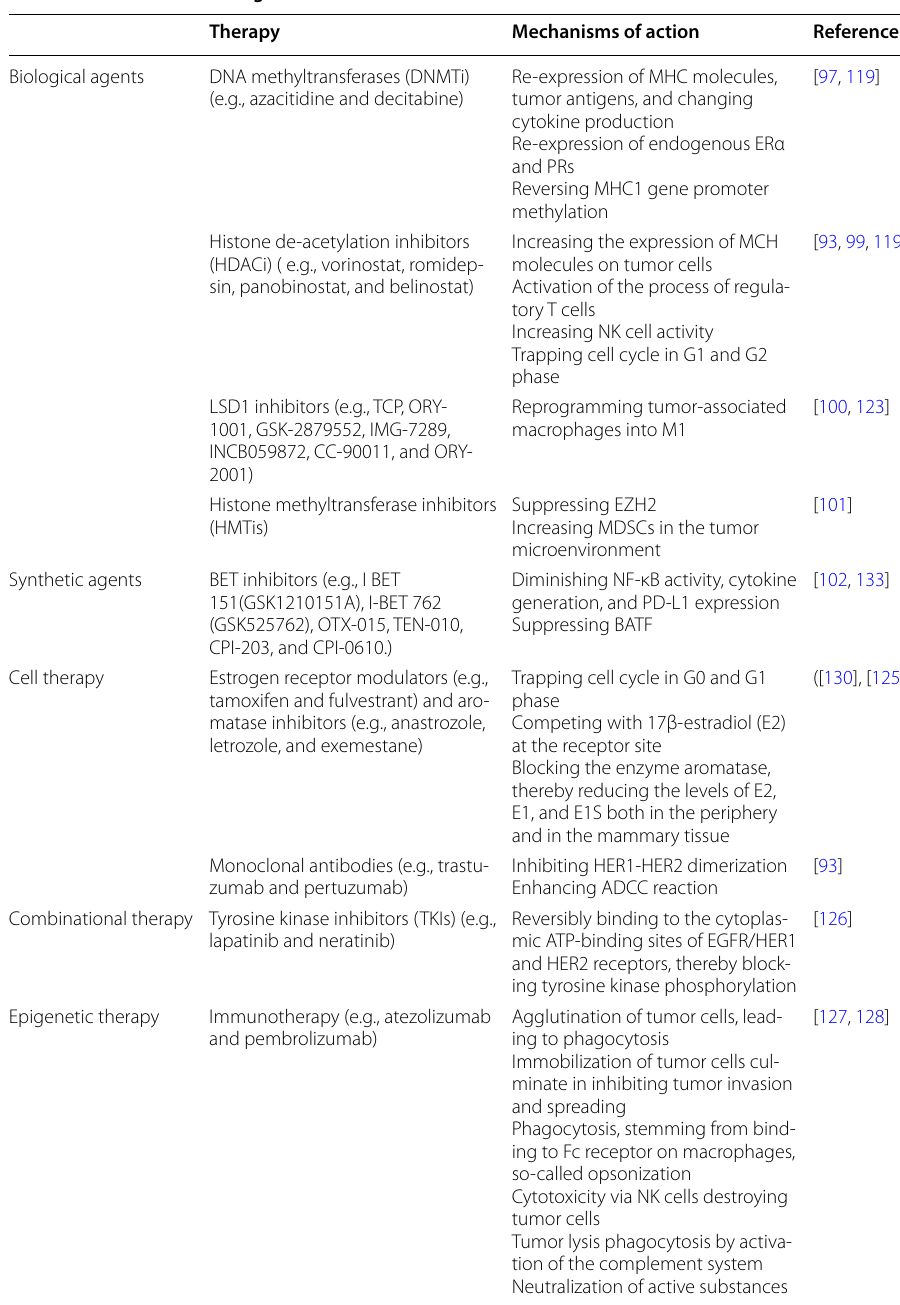
Table 5 New treatment strategies in breast cancer New/future treatment